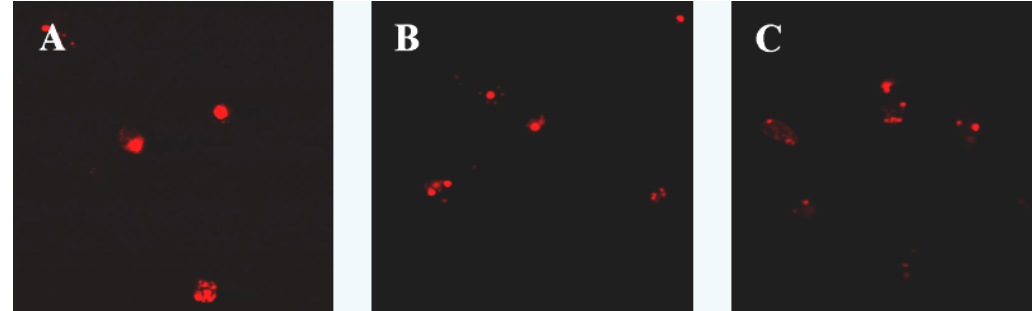
Figure 6. Effects of laminarin on intracellular fluorescent intensity of MPTP in LOVO. ( A ) Cells were treated as control group; ( B ) Cells were treated with 400 µg · mL − 1 laminarin; ( C ) Cells were treated with 800 µg · mL − 1 laminarin; ( D ) Cells were treated with 1,600 µg · mL − 1 laminarin; ( E ) Cells were treated with 5 µg · mL − 1